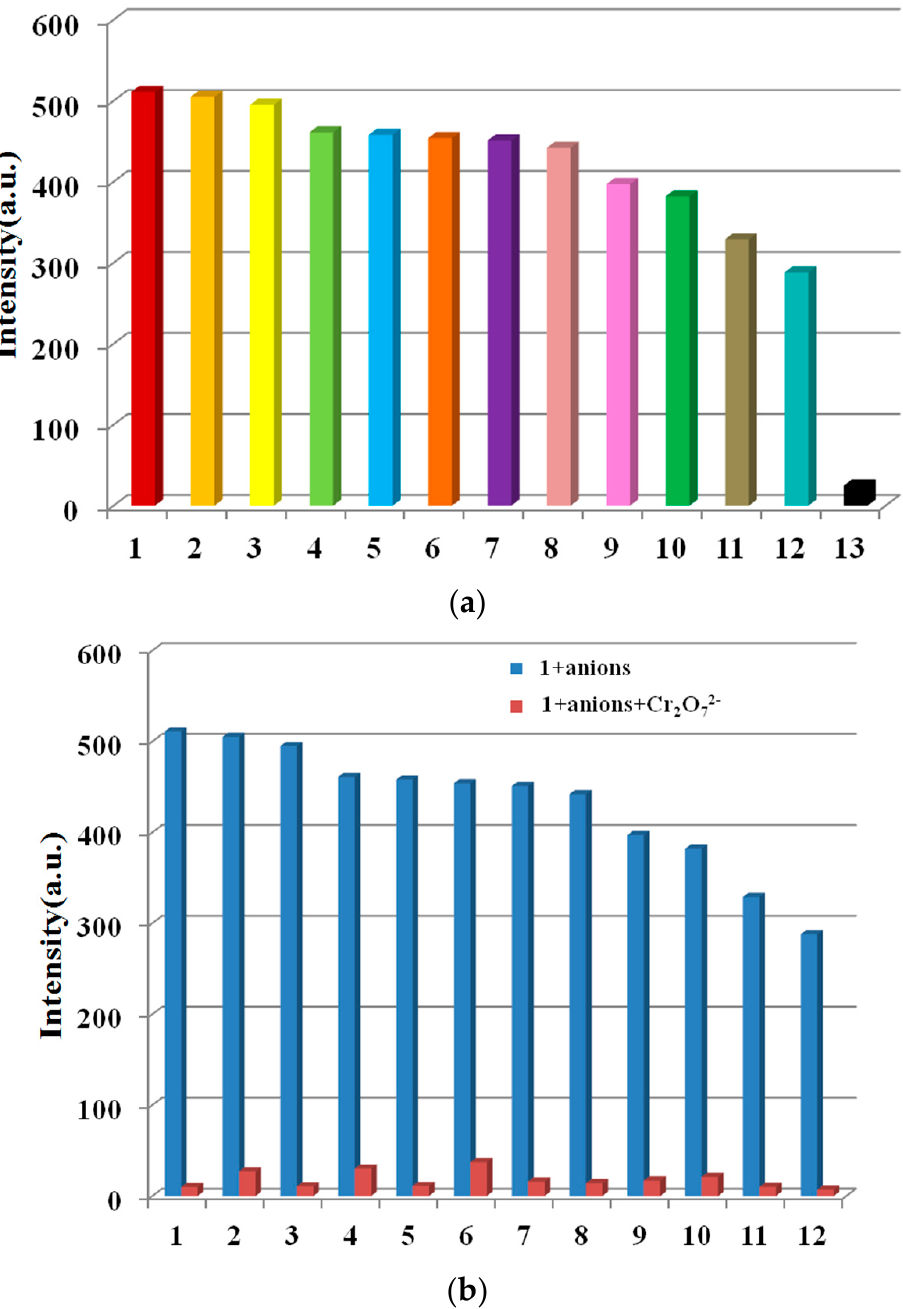
Figure 5. Luminescence intensity map of ( a ) complex 1 (1.5 mg) dispersed in aqueous solutions of multifarious metal ions (3 mL, 10 − 3 M) under the excitation of 275 nm and ( b ) with subsequent addition of Cr 2 O 72 − . (1) I − , (2) C 2 O 42 − , (3) HSO 3 − , (4) Br − , (5) SO 42 − , (6) F − , (7) NO 2 − , (8) H 2 PO 4 − , (9) S 2 O 82 − , (10) SCN − , (11) Cl − , (12) Ac − , and (13) Cr 2 O 72 − .